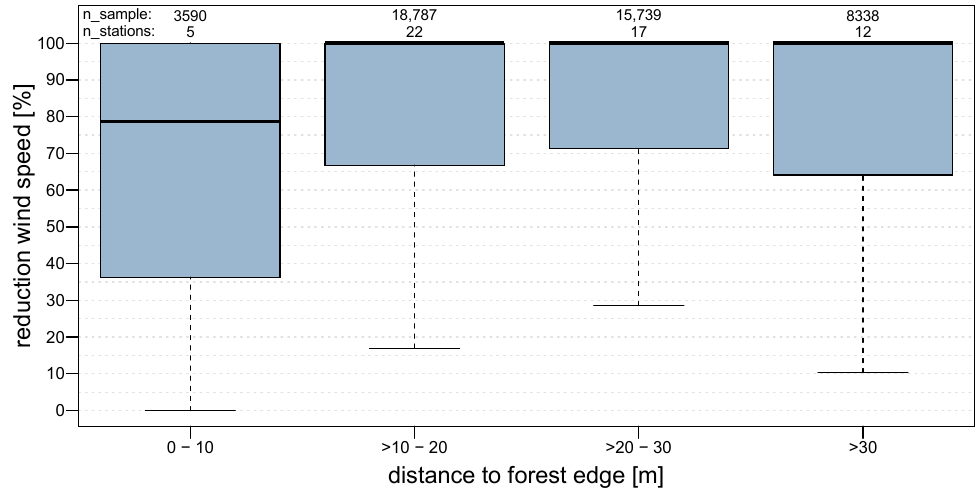
Figure 6. Dependance of wind speed reduction due to distance to the forest edge.